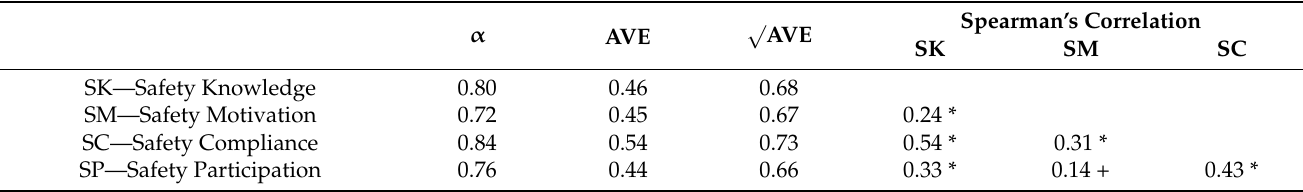
Table 3. Internal consistency (Cronbach’s alpha), convergent and discriminant validity, and construct validity (Spearman’s